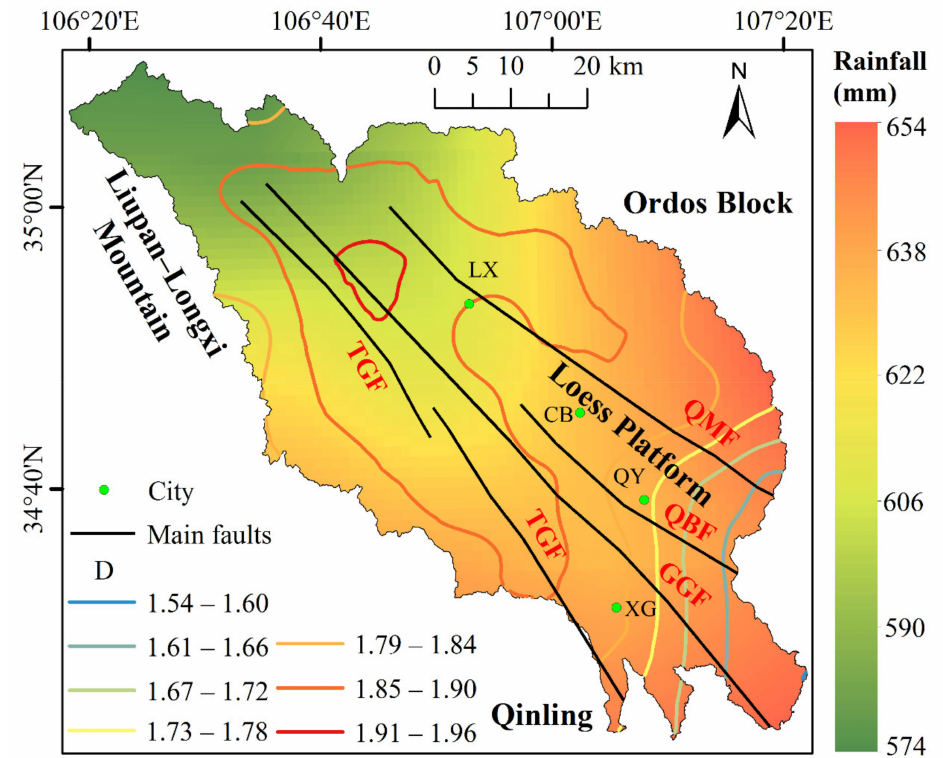
Figure 9. Annual mean rainfall map in 2000–2020 in the Qianhe Graben, resampled from the Tropical Rainfall Measuring Mission (TRMM TMPA/3B43, https://trmm.gsfc.nasa.gov/ (accessed on 29 December